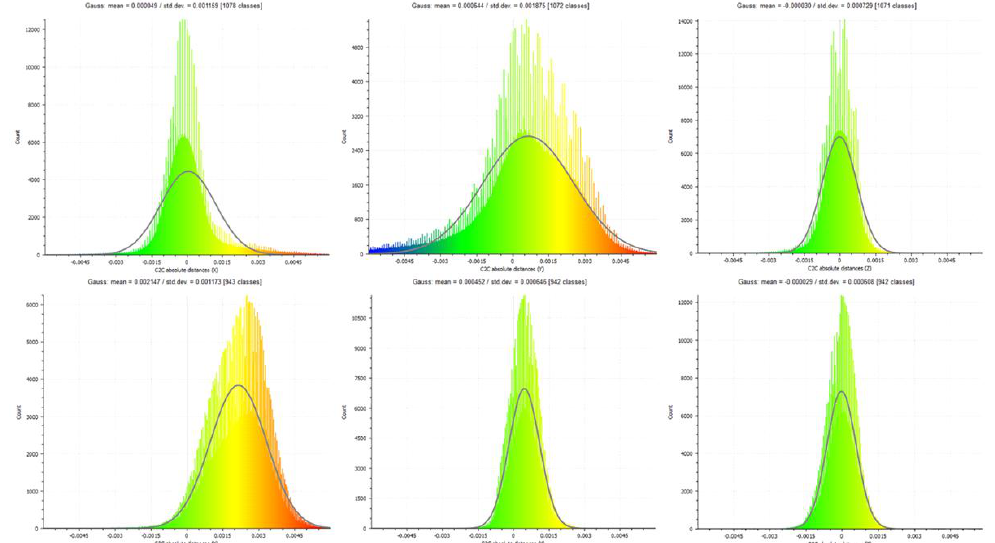
Figure 7. Histograms of deviations on test sections between clouds of points created during stages I and II